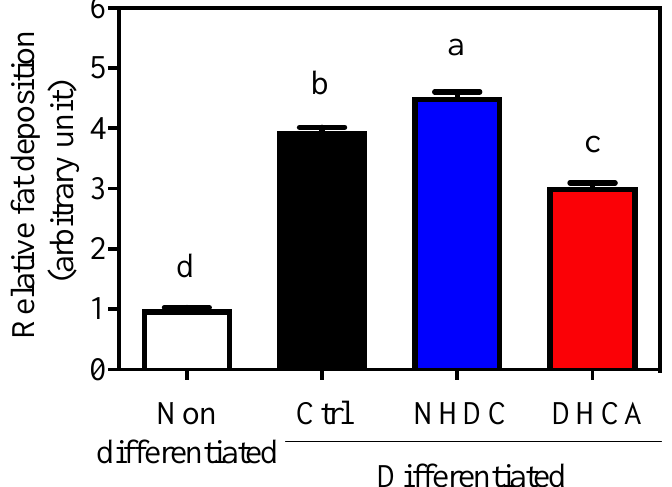
Figure 3. Suppressed lipid accumulation on 3T3-L1 by DHCA ( A ) Relative Oil Red O absorbance of 3T3-L1 adipocytes with 500 µ M of NHDC or DHCA treatment. 3T3-L1 preadipocytes differentiated into adipocytes with NHDC or DHCA. After 10 days from differentiation, adipocytes were stained with Oil Red O. Fat deposition was quantified by absorbance at 490 nm. The relative values are calculated by setting the Abs of the non-differentiated group as 1. The results were reported as means SEMs ( n = 4). a – d Statistical significance is shown with different letters ( p < 0.05).